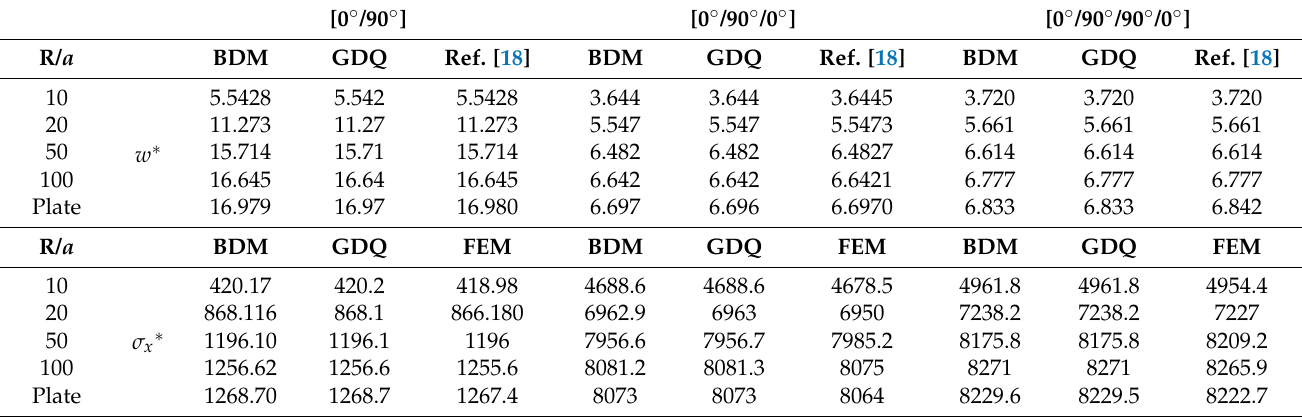
Table 1. Normalized central deflections and stresses of cross-ply laminated shells under distributed load ( a / h =